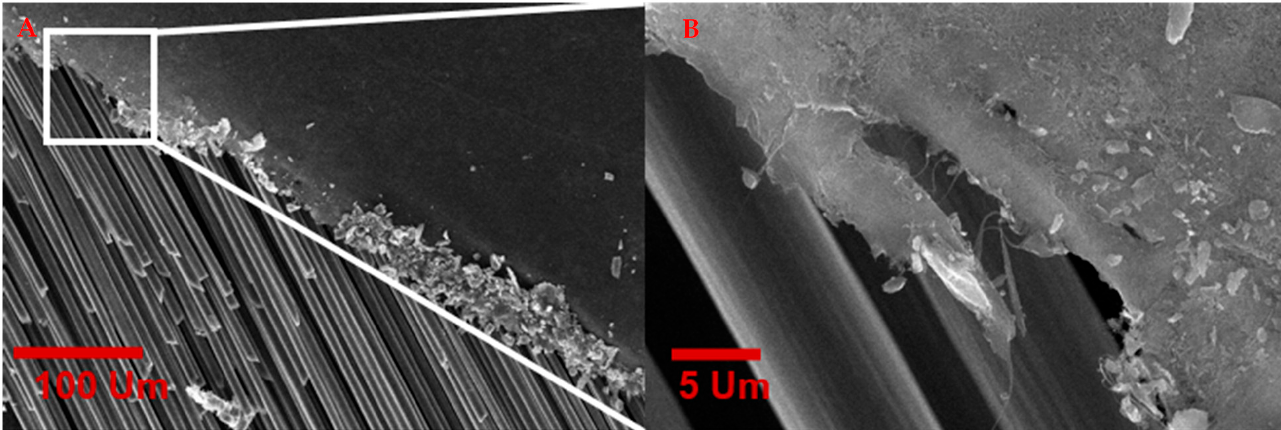
Figure 18. Thermogravimetric analysis graph for chopped carbon fiber and CNT-integrated chopped fiber (there is no polymer).